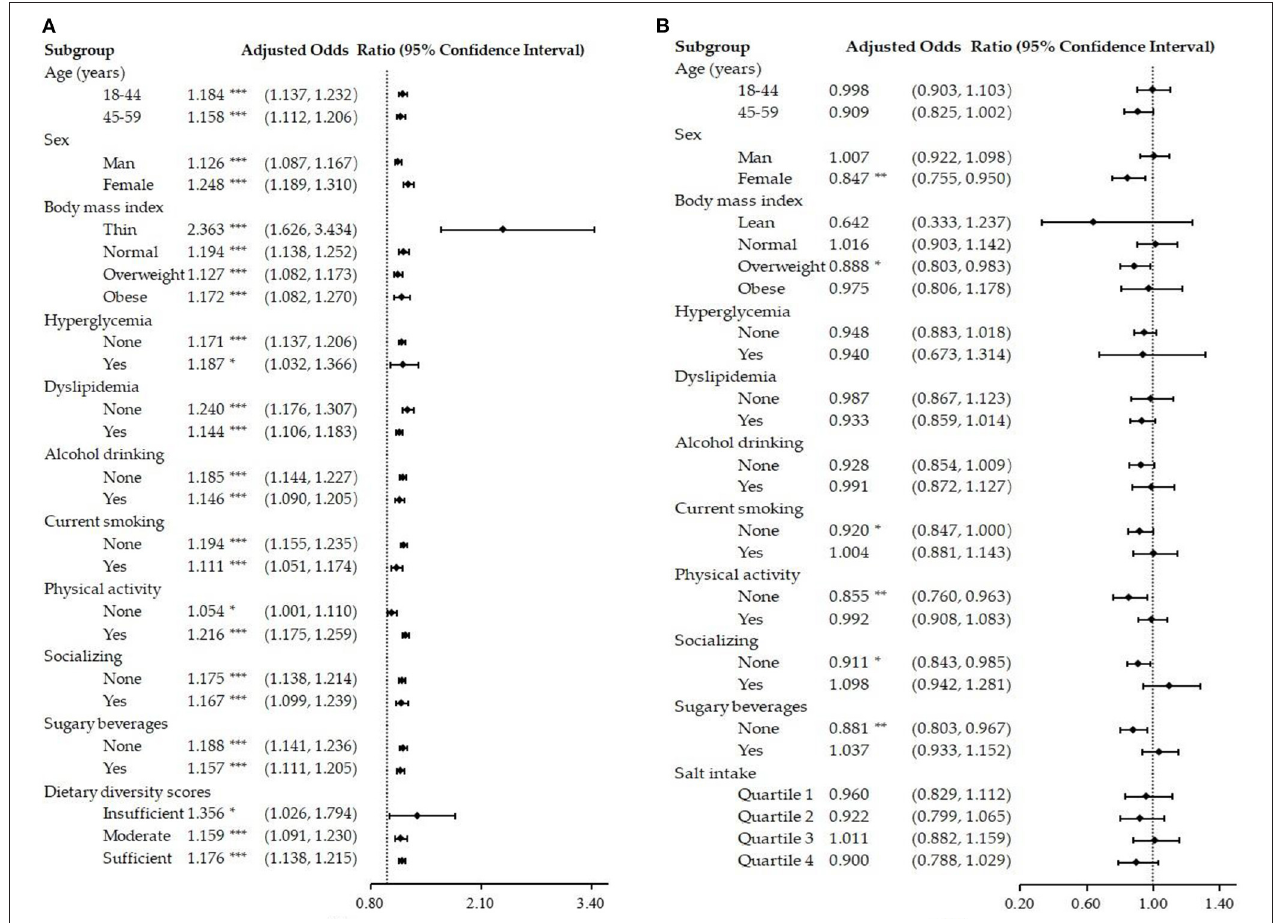
FIGURE 3 | Subgroup analysis of the salt intake, dietary diversity, and NAFLD. (A) Association of salt intake with NAFLD after adjusting for other confounding variables; (B) Association of dietary diversity with NAFLD after adjusting for other confounding variables. NAFLD, non-alcoholic fatty liver disease; Insufficient refers to a score of 0–3, Moderate refers to a score of 4–6, and Sufficient refers to a score of 7–9; * P < 0.05; ** P < 0.01; *** P <